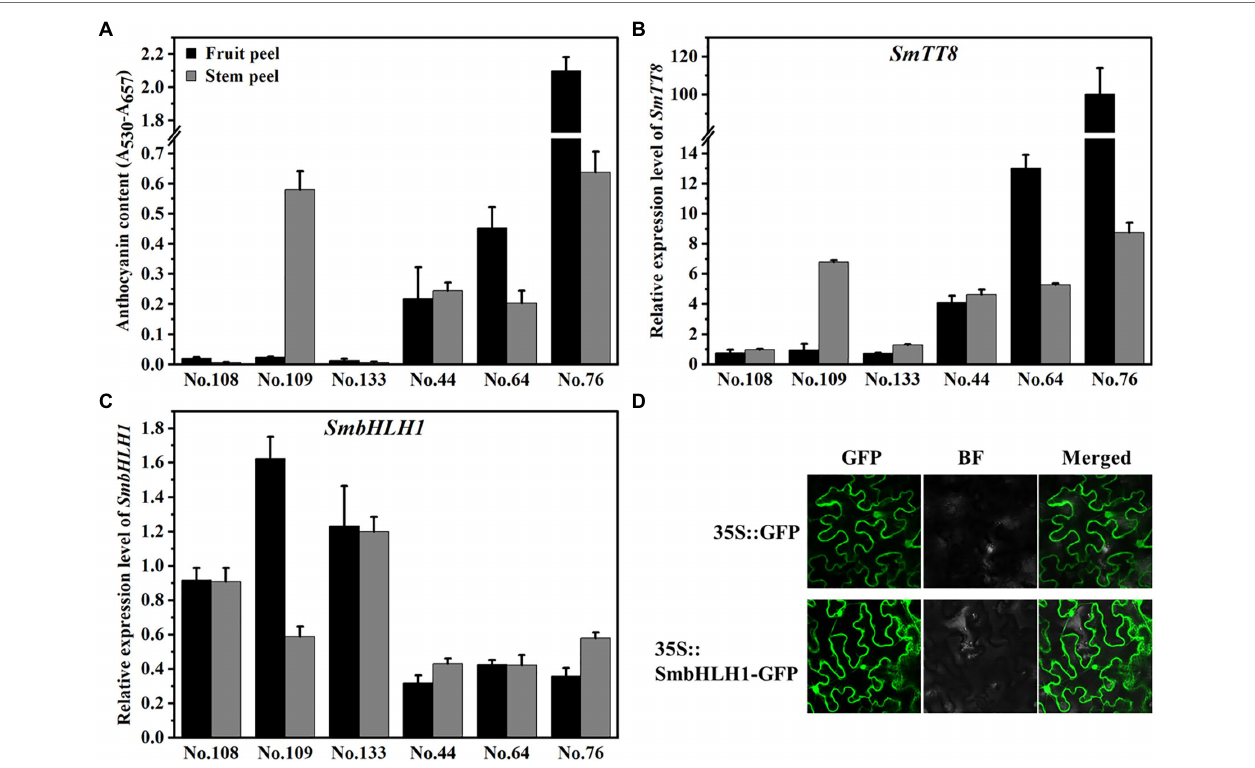
FIGURE 2 | Relationship of anthocyanin contents with the expression of SmTT8 and SmbHLH1 . (A) The anthocyanin contents in the fruit and stem peels of six eggplant cultivars; (B,C) The expression levels of SmTT8 and SmbHLH1 in the fruit and stem peels of six eggplant cultivars. Bars represent means ± SD of three biological replicates; and (D) Subcellular localization analysis of